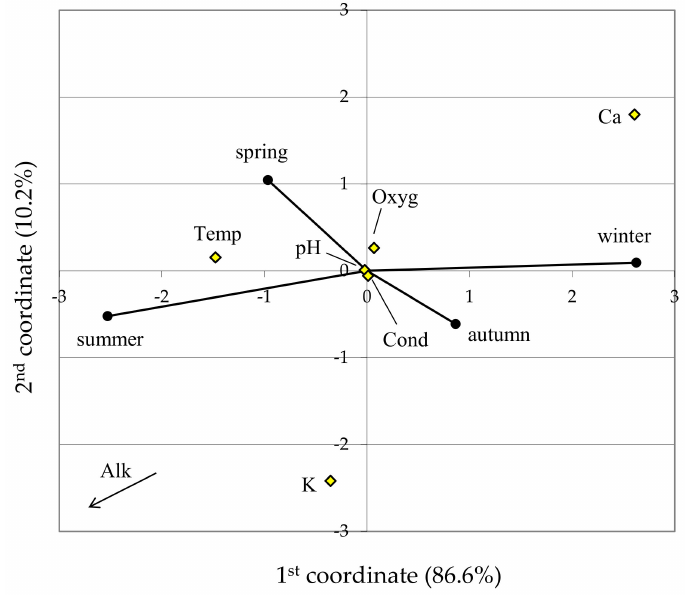
Figure 14. Position of measuring series determined by physicochemical parameters and macroele- ments in the space of the first two canonical varieties and spacing of these parameters in the dual space (trait coordinates rescaled and multiplied by 0.4).